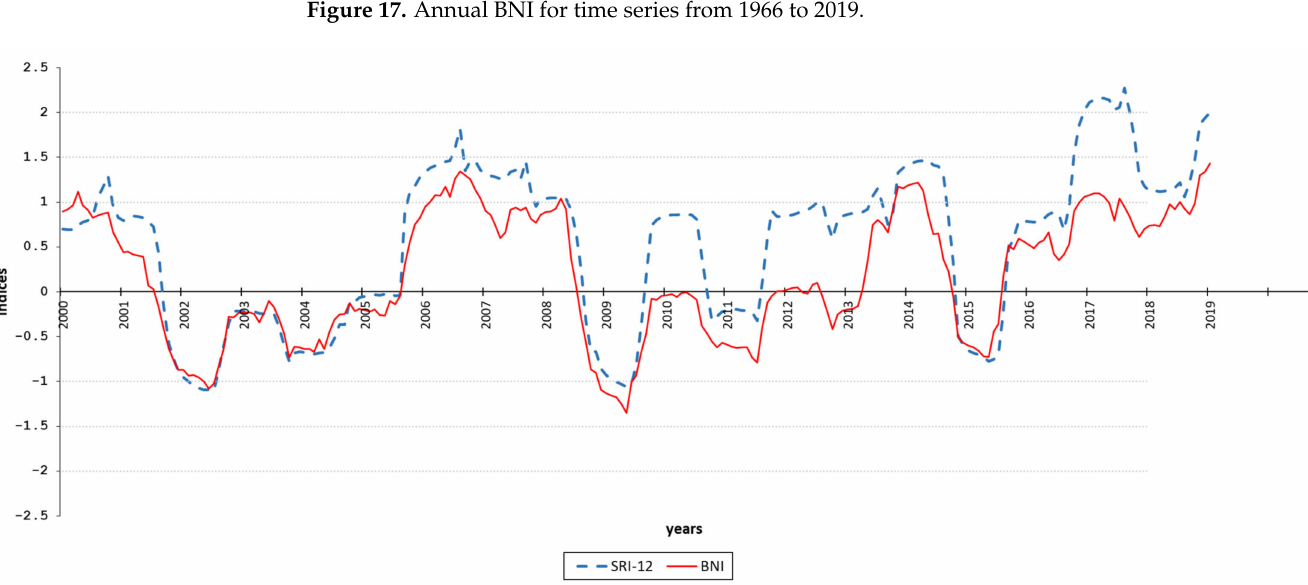
Figure 18. The 12-month BNI and SRI at El